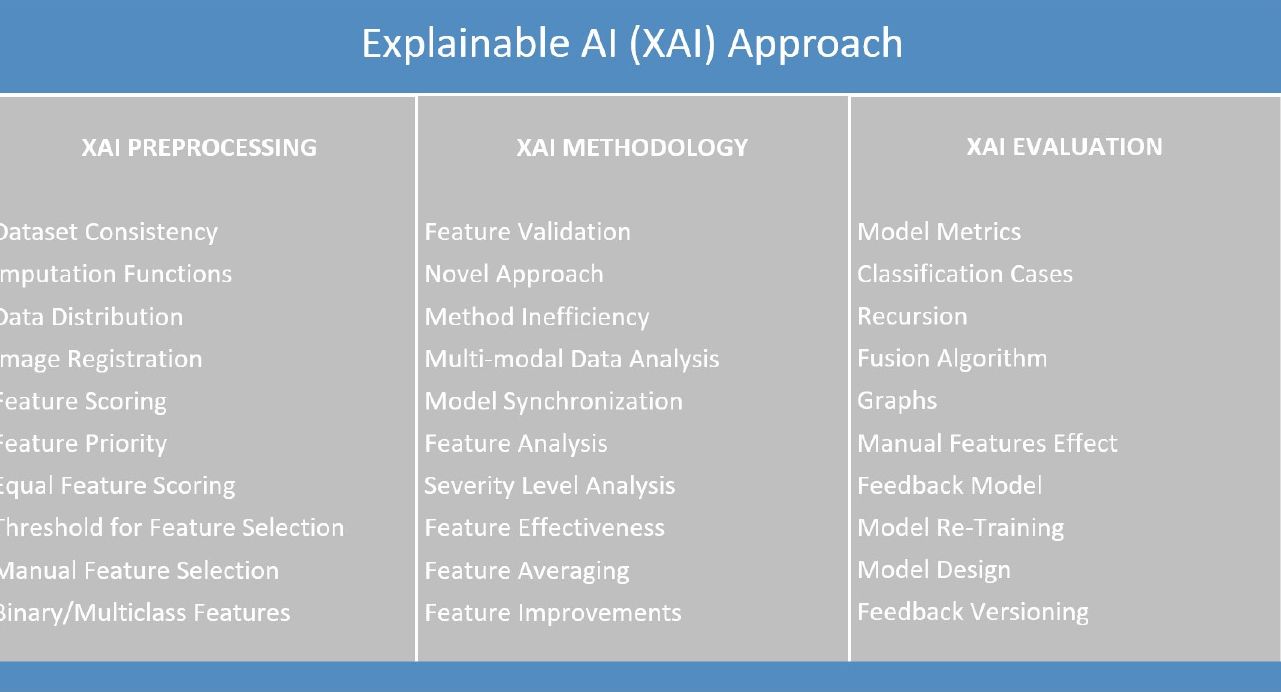
Figure 6. Explainable AI Approach Planning.